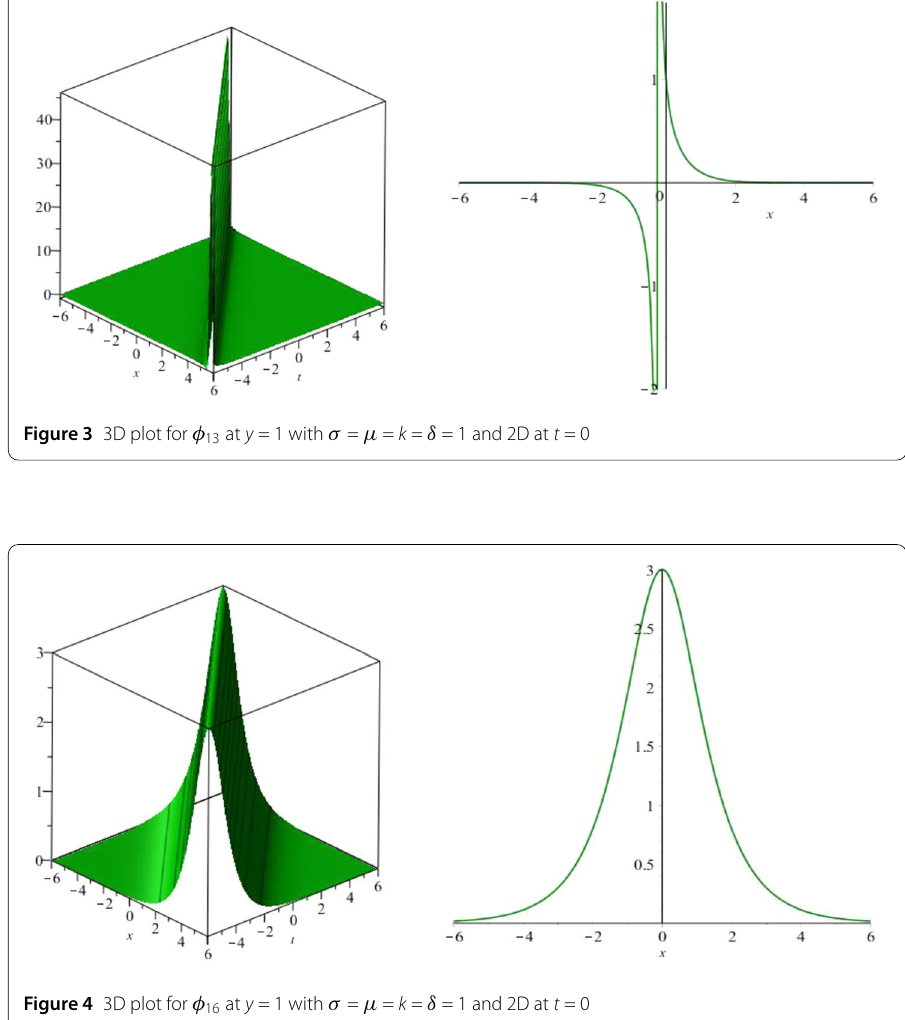
4 Stability analysis of Eq.